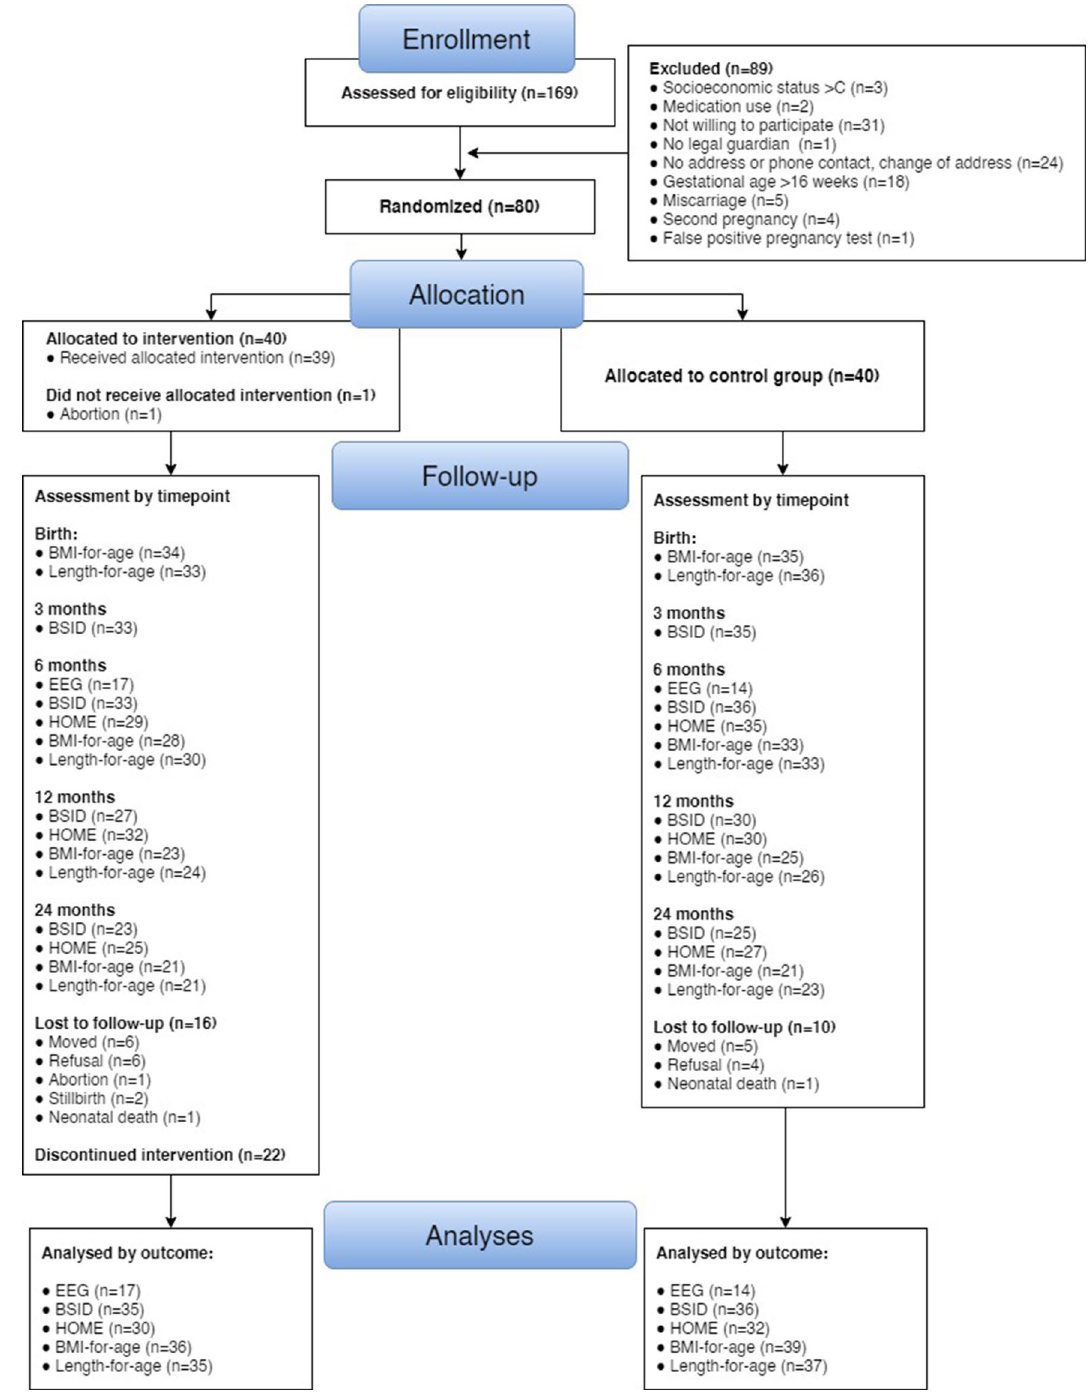
Figure 1. CONSORT flow diagram of the randomized controlled